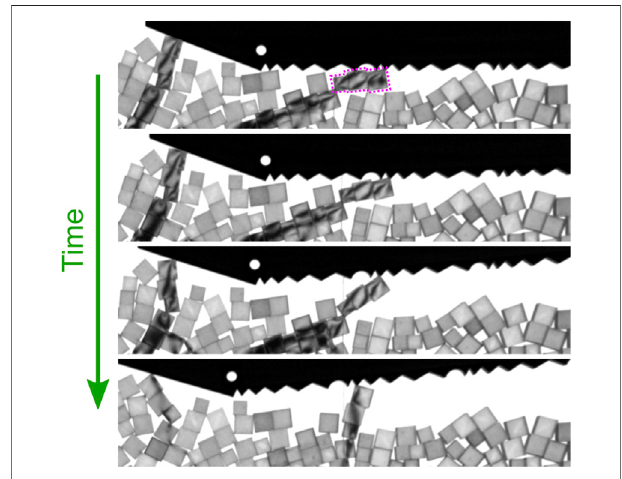
FIGURE 9 | A sample sticking period in which the slider contacts a column of square grains (purple dotted outline in top segment) that rotates as thehorizontalforcefromthesliderincreases.Theangleandverticalpositionof the slider increase because of the rotation of this columnar stilt.